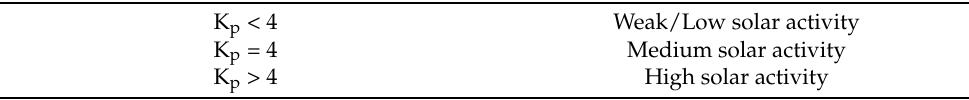
Table 1. K p index activity classification. K p <